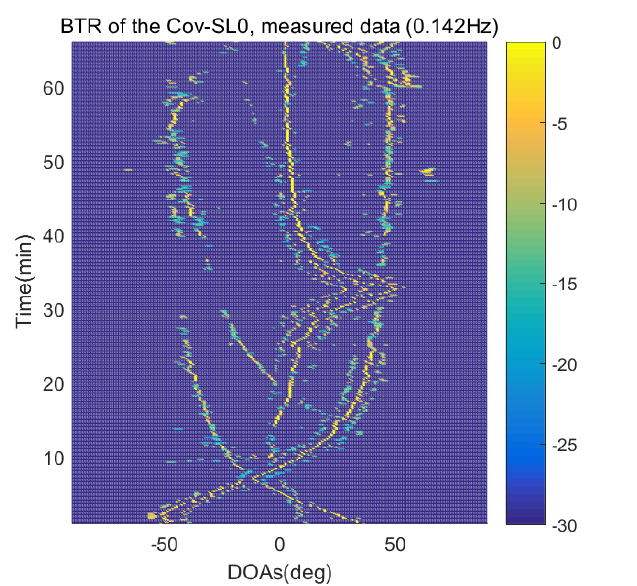
Figure 17. Bearing time records of the proposed scheme: 66 min, signal frequency = 0.142